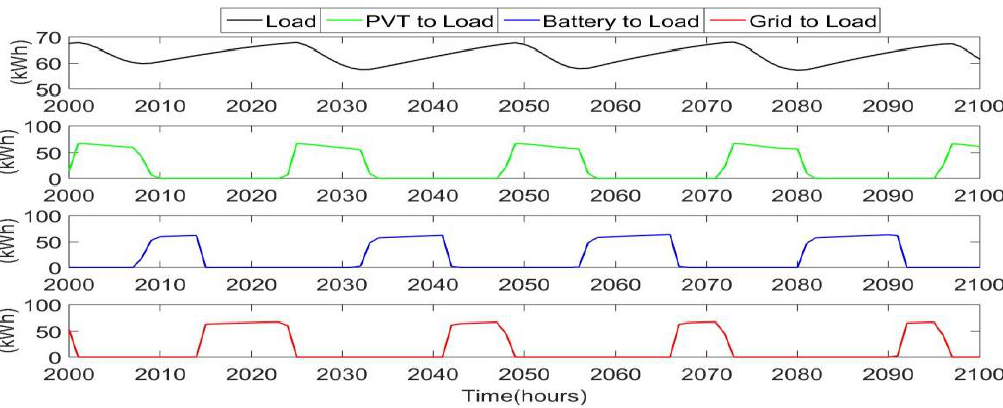
Figure 6. Electrical dispatching to meet the load, including direct power from PVT, stored battery power, and grid power.